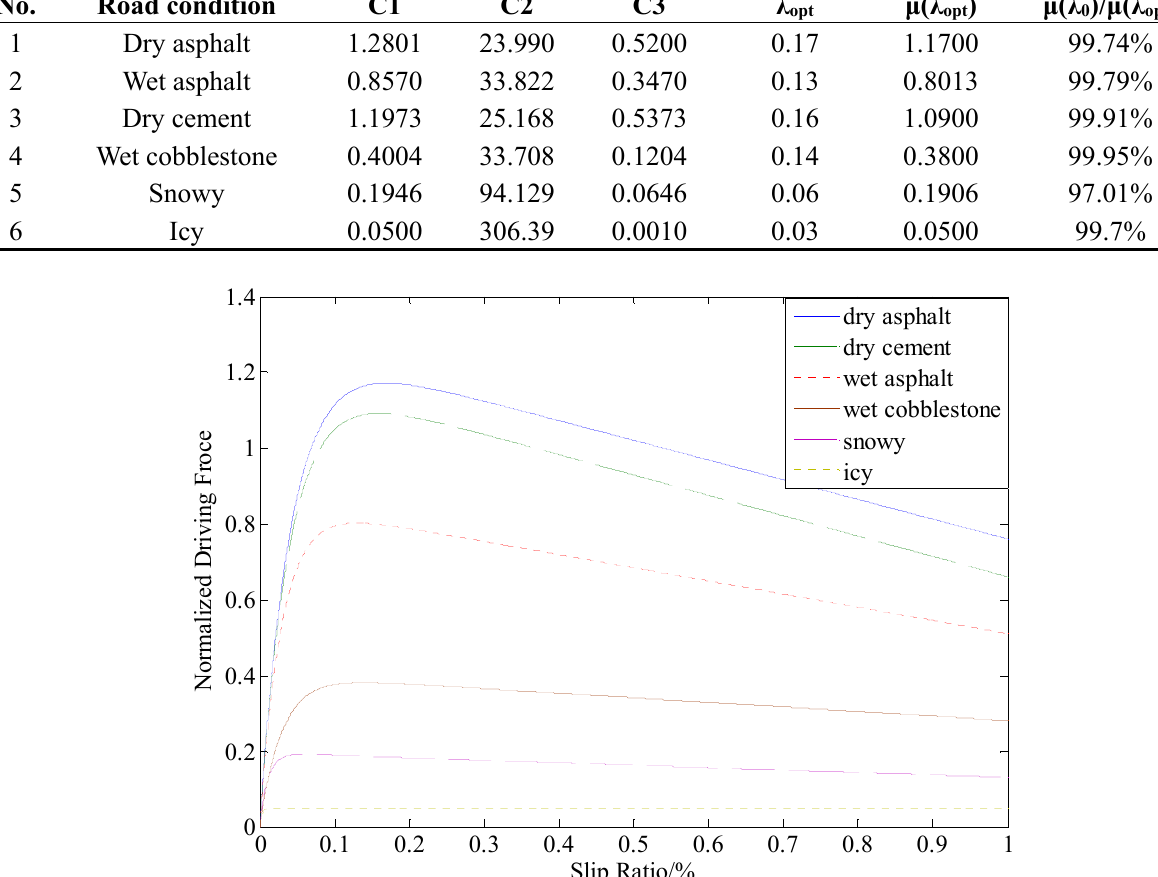
Figure 5. μ - λ curves of standard road